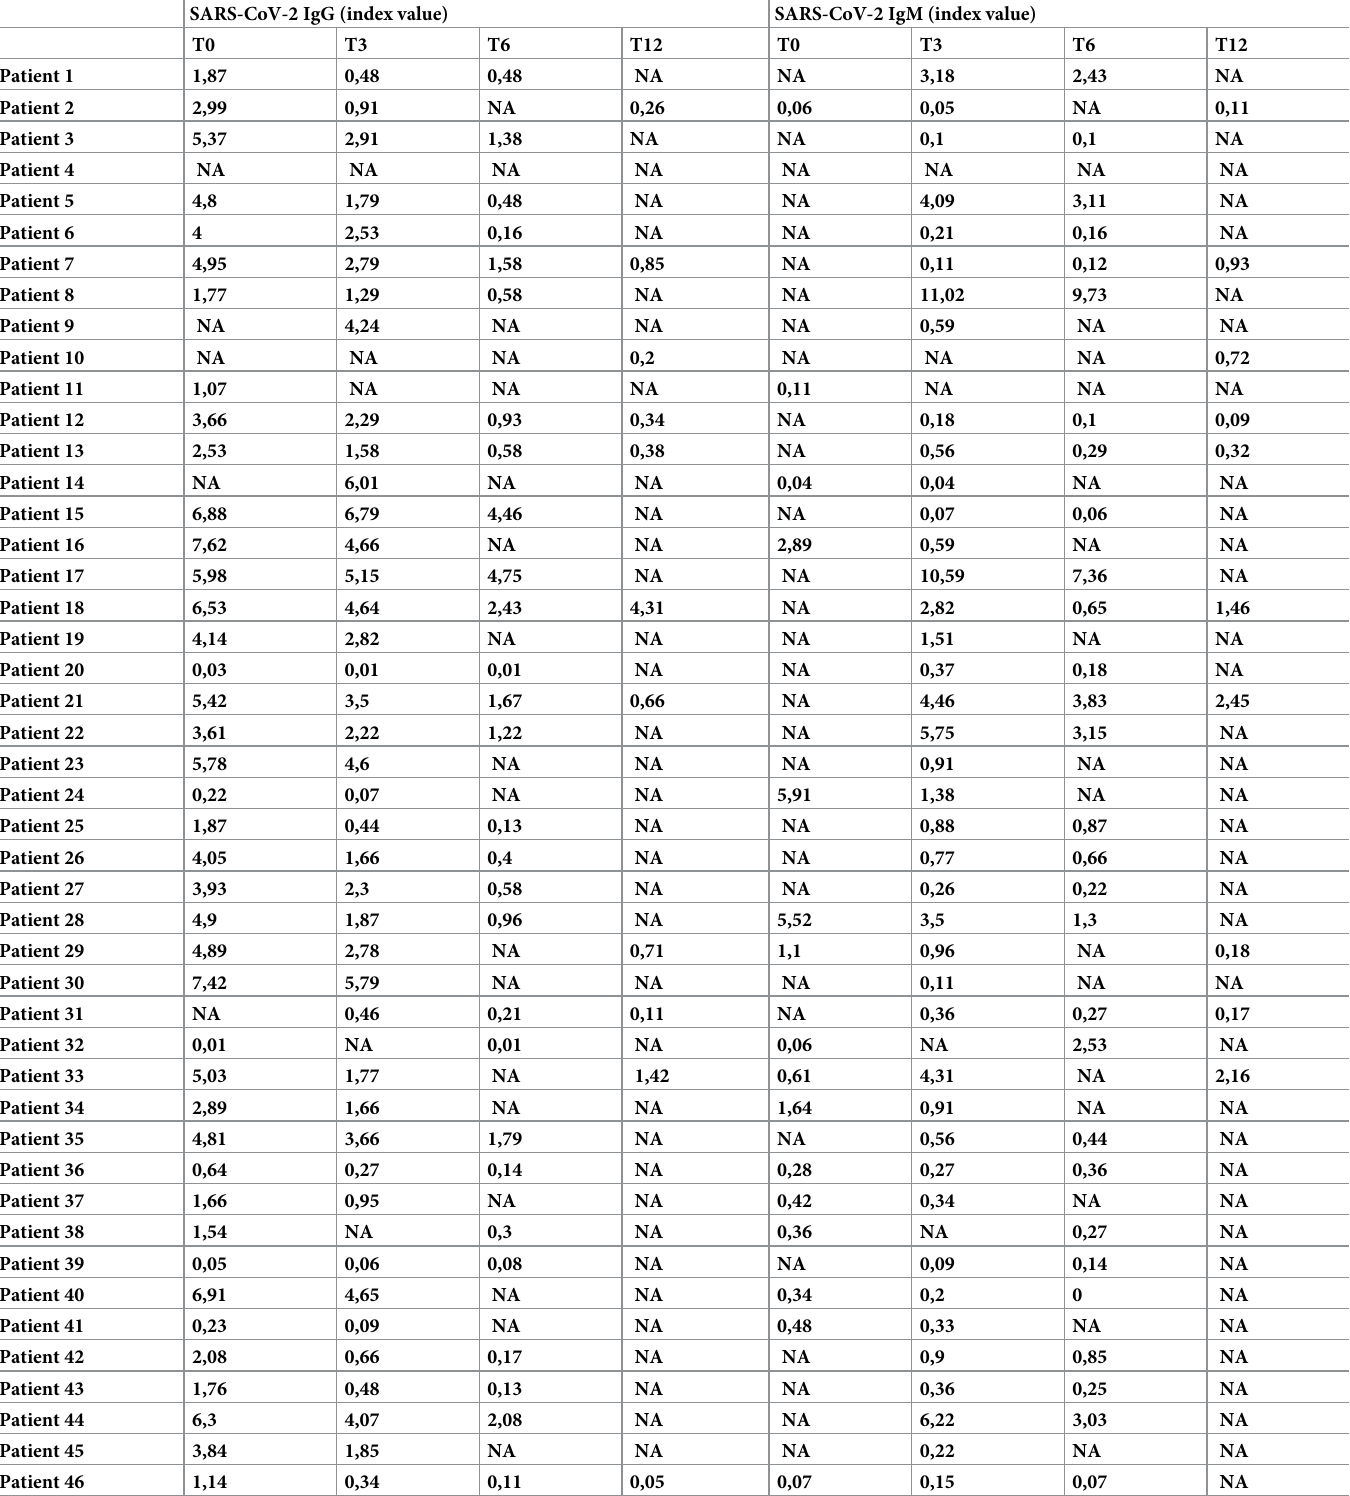
Table 1. Serum levels of IgG and IgM antibodies determined at baseline (T0), month 3 (T3), month 6 (T6) and month 12 (T12). SARS-CoV-2 IgG (index